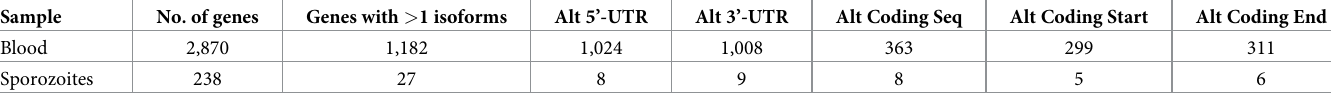
Table 2. Summary of isoform types from PacBio